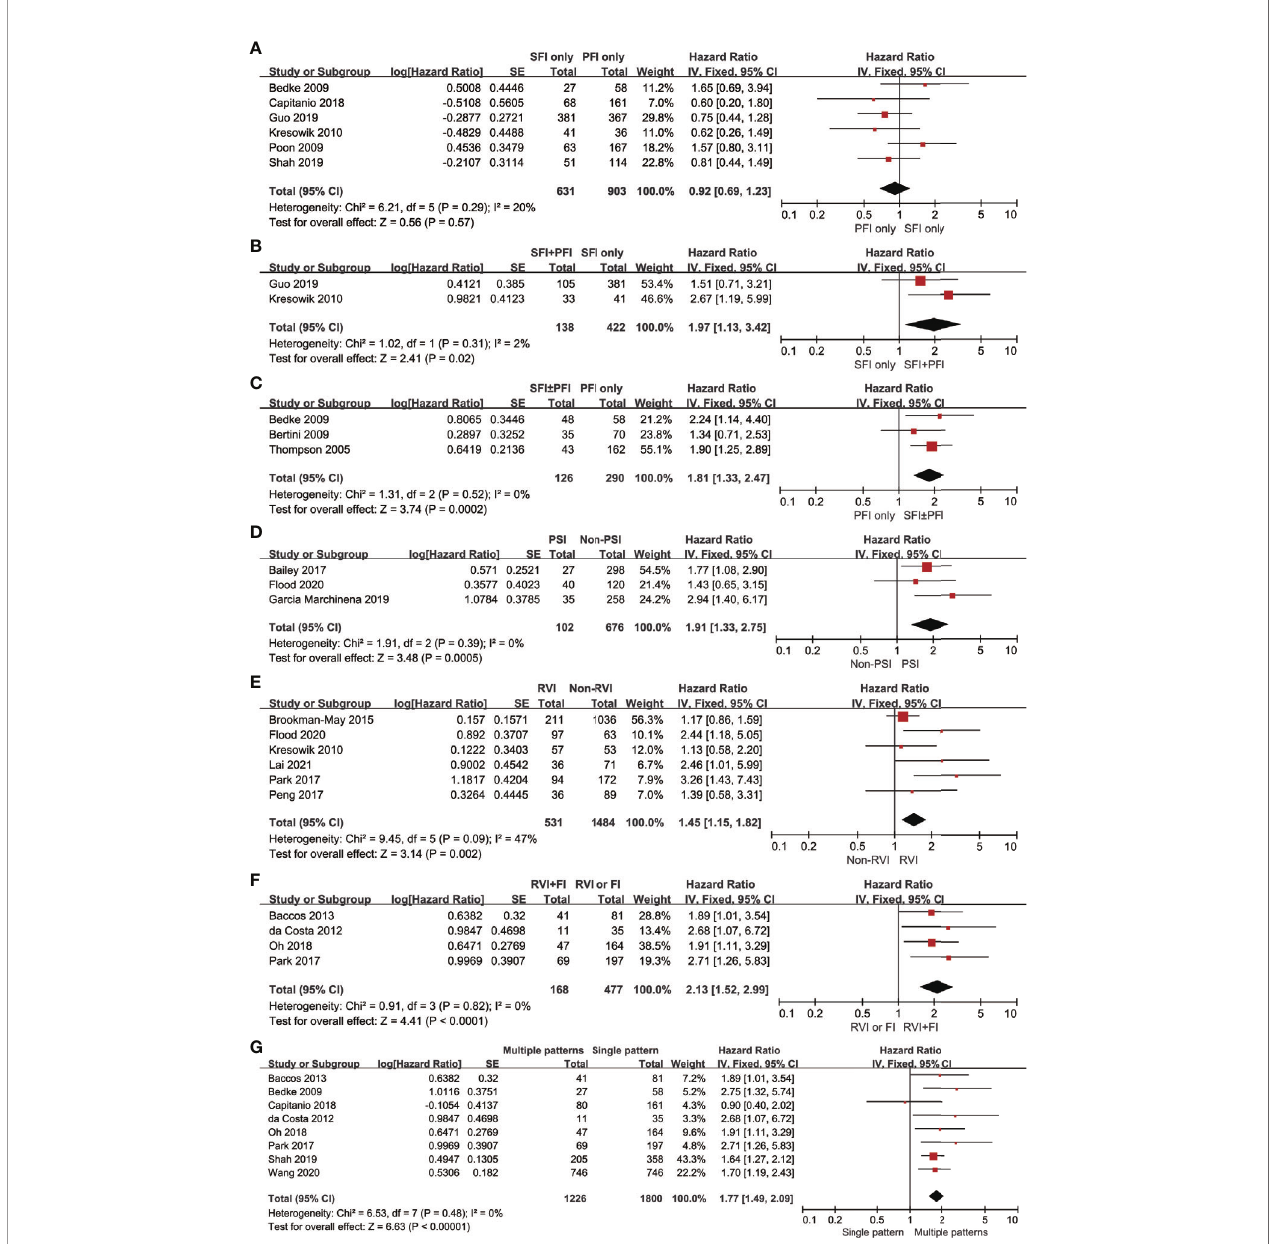
FIGURE 3 | Forrest plots of hazards ratio (HR) evaluating the signi fi cant predictors of cancer-speci fi c survival for different pT3a renal tumor invasion patterns. (A) : SFI only vs PFI only; (B) : SFI + PFI vs SFI only; (C) : SFI ± PFI vs PFI only; (D) : PSI vs non-PSI; (E) : RVI vs non-RVI; (F) : RVI + FI vs RVI or FI; (G) Multiple patterns vs Single pattern. SFI, sinus fat invasion; PFI< perinephric fat invasion; PSI, pelvicaliceal system invasion; RVI, renal vein invasion; FI, fat